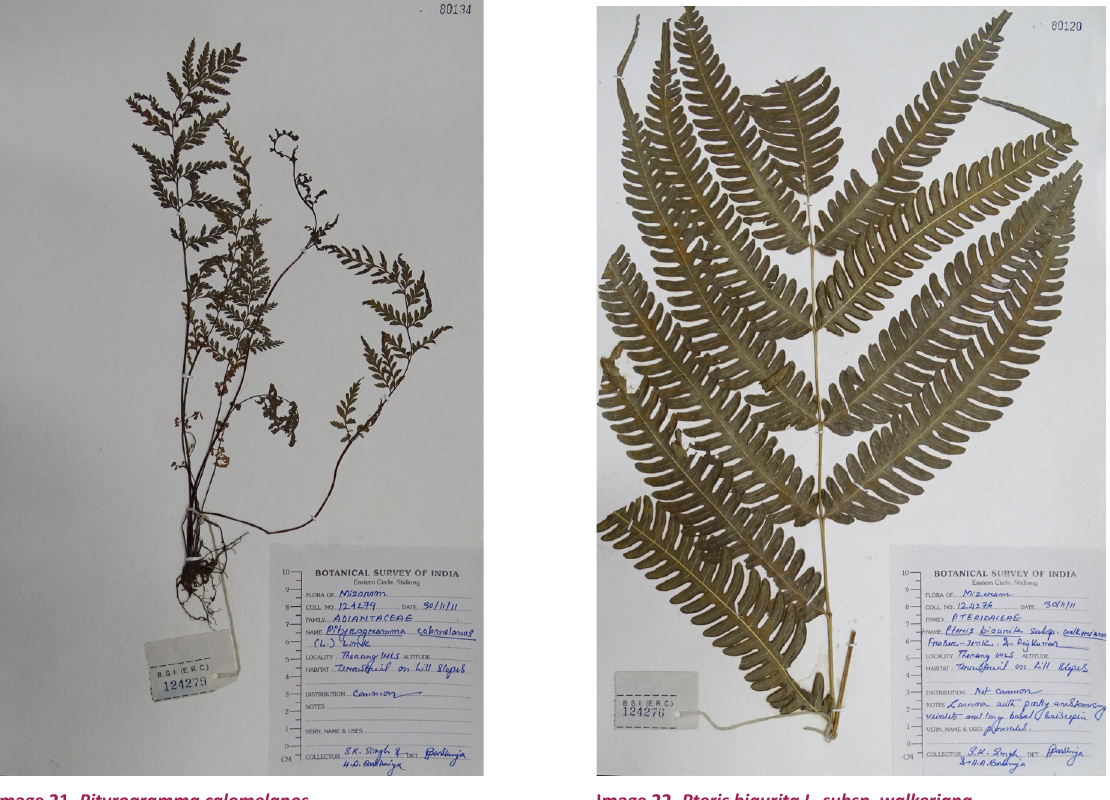
Image 22. Pteris biaurita L. subsp. walkeriana